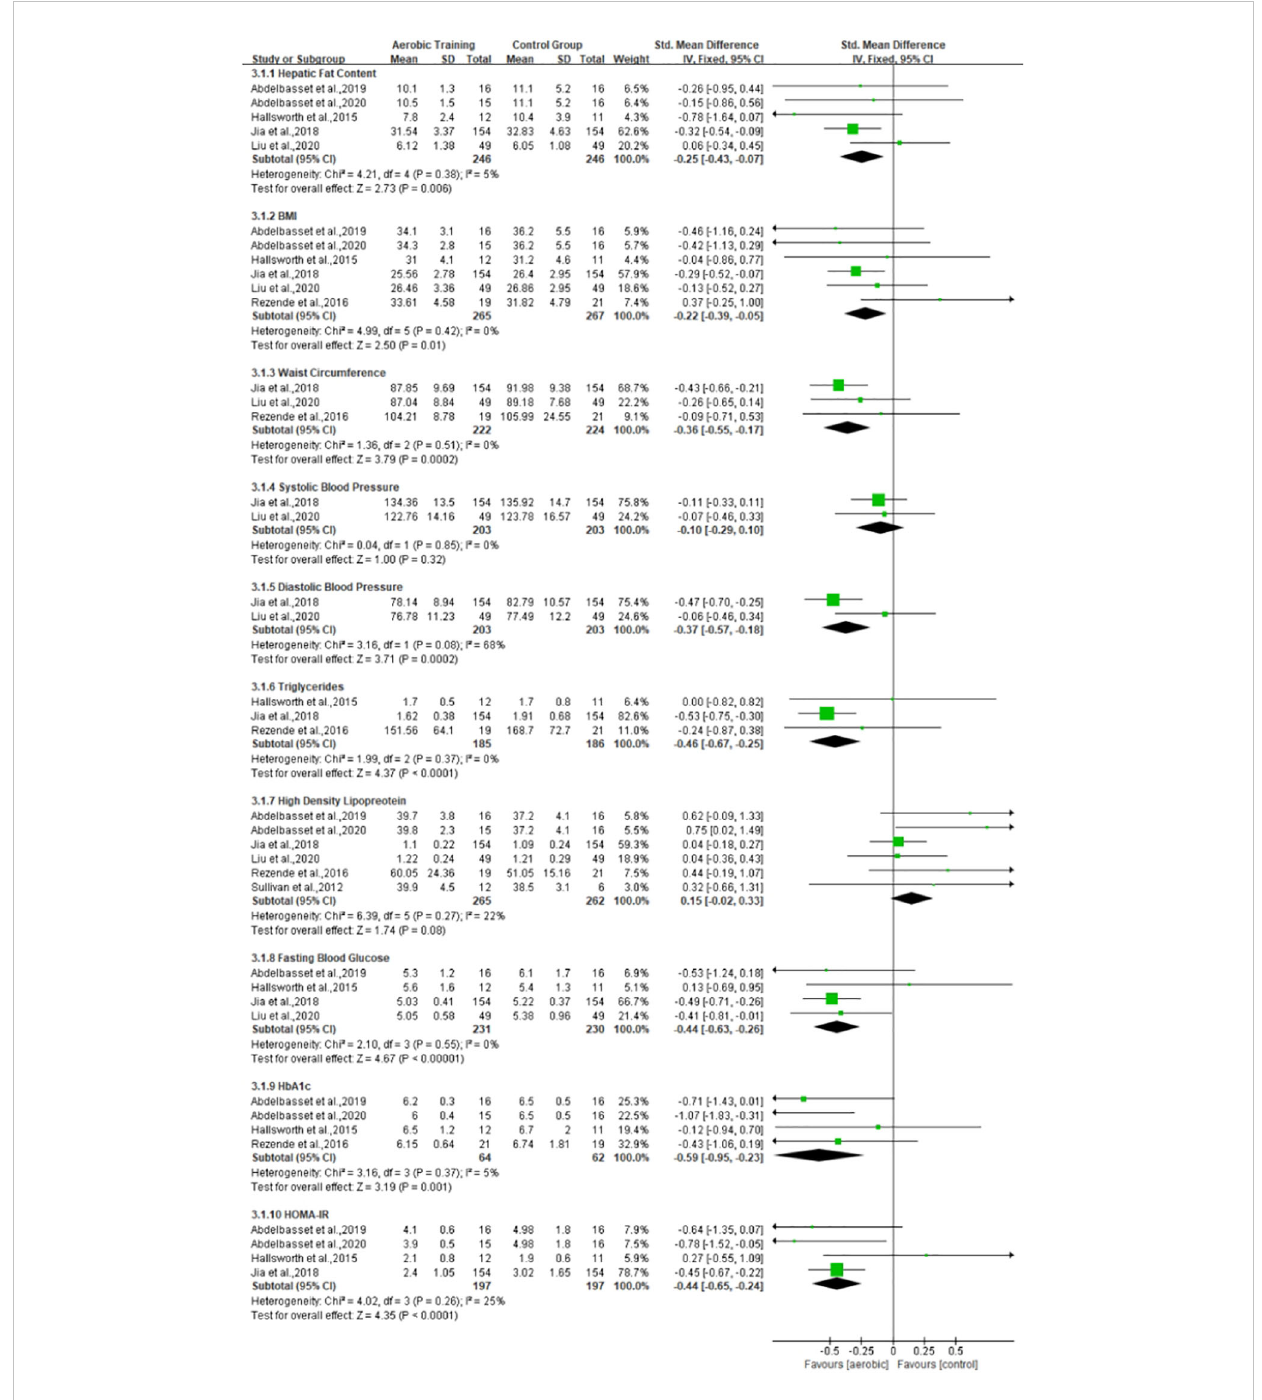
FIGURE 3 Effect of aerobic training vs . control group on